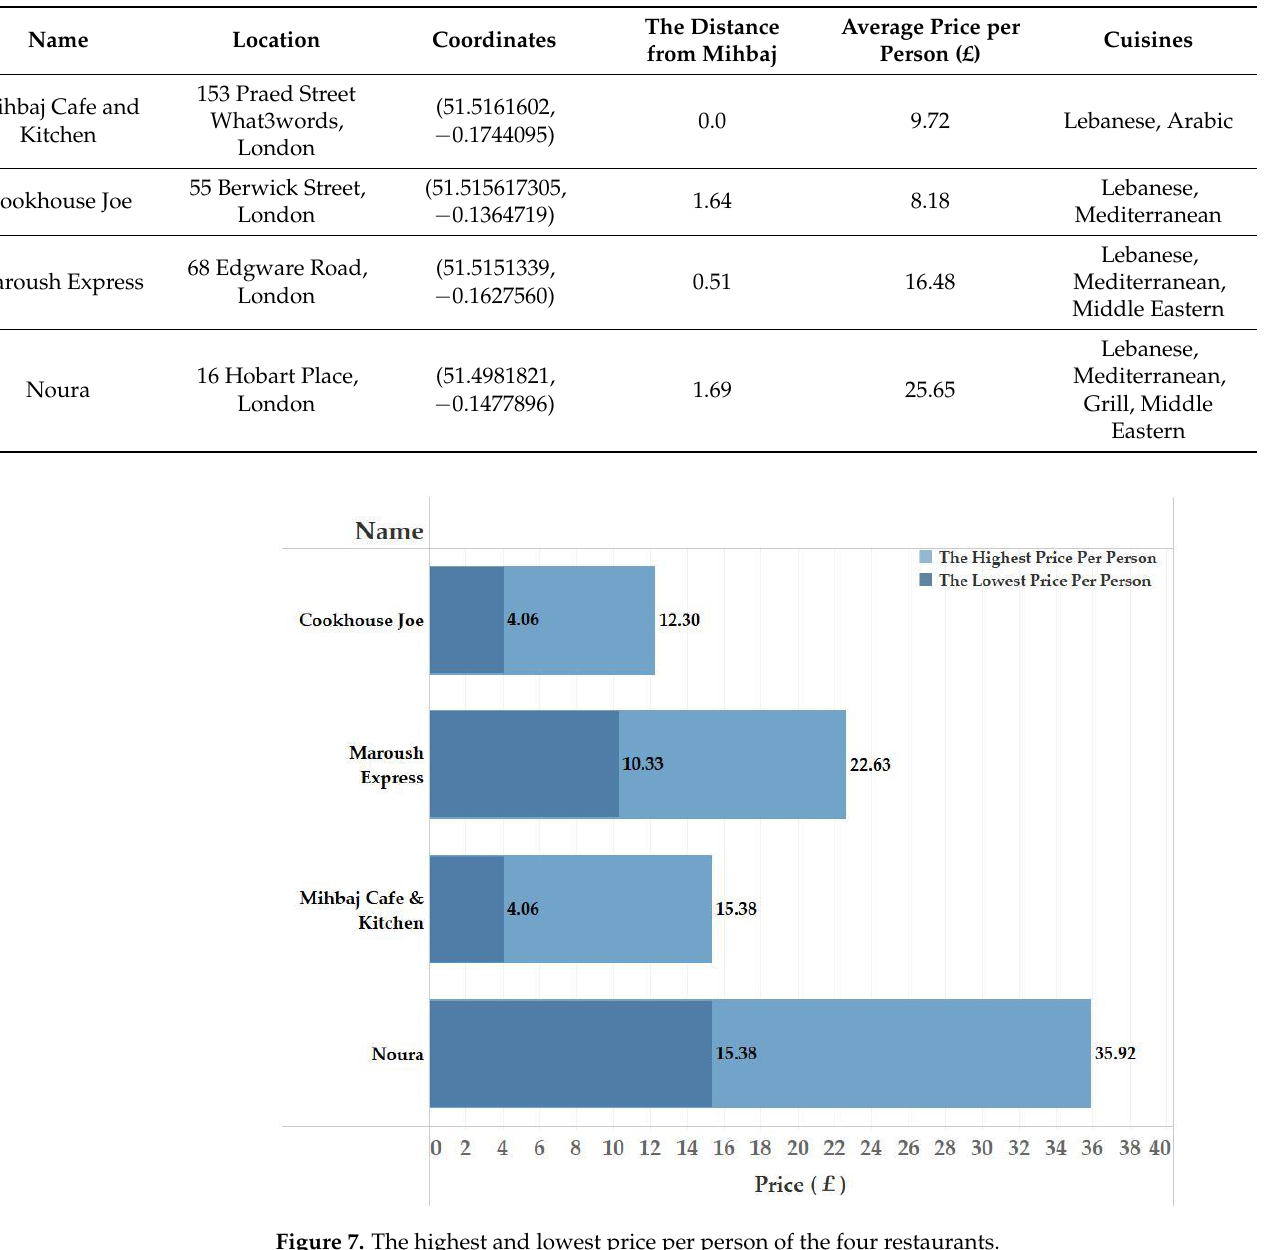
Figure 7. The highest and lowest price per person of the four restaurants.